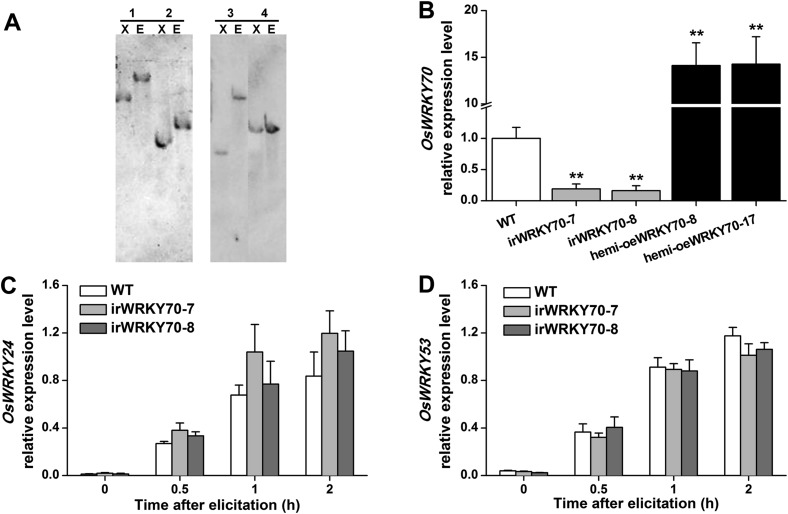
OsWRKY70 transgenic lines and levels of OsWRKY70, OsWRKY24, and OsWRKY53 transcripts in the transgenic lines and WT plants.(A) Southern blot analysis of transgenic lines with silencing (irWRKY70 lines, irWRKY70-7, and irWRKY70-8) or overexpressing (hemizygous lines, hemi-oeWRKY70 lines, hemi-oeWRKY70-8, and hemi-oeWRKY70-17) of OsWRKY70. Genomic DNA was digested with XbaⅠ(X) and EcoRⅠ(E). The Blot was hybridized with a probe specific for gus reporter gene. All transgenic lines have a single insertion of the transgene. Lane 1, irWRKY70-7; lane 2, irWRKY70-8; lane 3, hemi-oeWRKY70-8; lane 4, hemi-oeWRKY70-17. (B) Mean expression levels (+SE, n = 6) of OsWRKY70 in irWRKY70, hemi-oeWRKY70, and WT plants at 1 hr after infestation by SSB. (C, D) Mean transcript levels (+SE, n = 5) of OsWRKY24 (C) and OsWRKY53 (D) in irWRKY70, hemi-oeWRKY70, and WT plants at different time after infestation by SSB. Asterisks indicate significant differences in irWRKY70 and hemi-oeWRKY70 compared with WT plants (**, p < 0.01; Student's t-test).